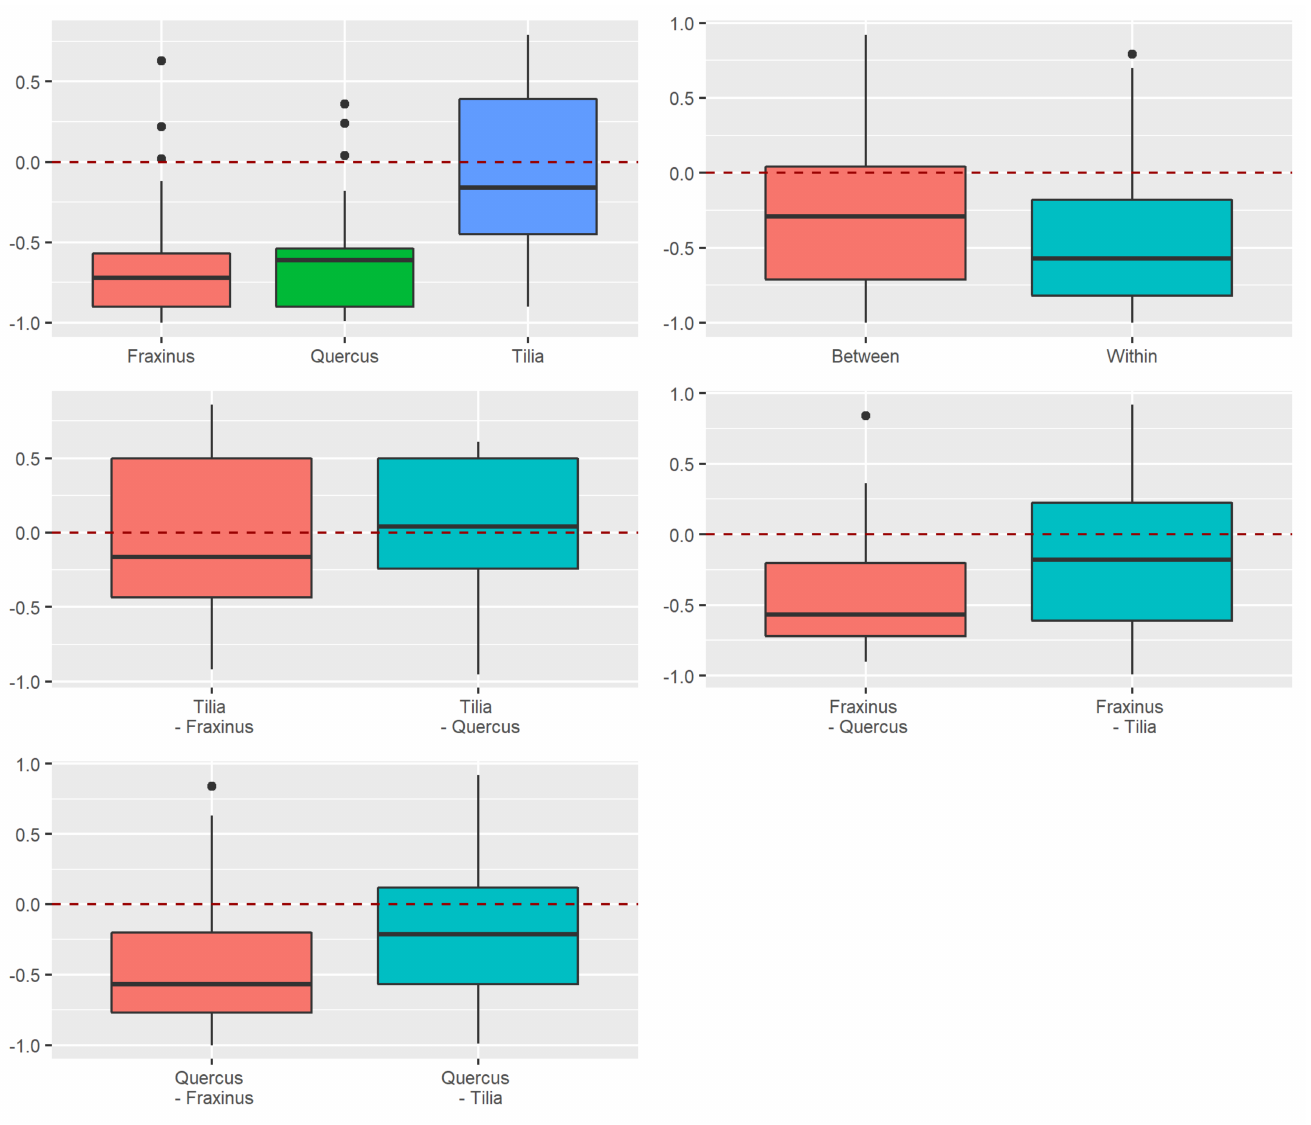
Figure A11. Deviation of the beta diversity from the diversity expected by the null hypothesis per tree species for the common beetle species, rarity classification according to the octaves. Comparisons within a tree species are comparisons of two traps of the same tree species. Comparisons between tree species are comparisons of two traps from two different tree